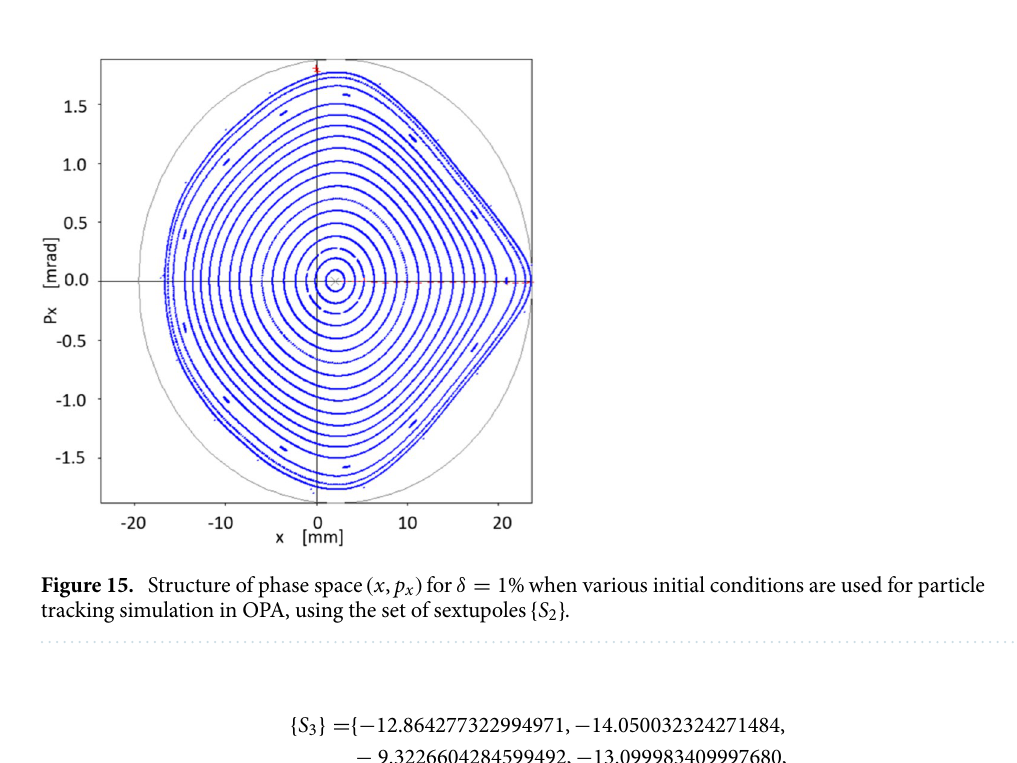
Figure 14. Structure of phase space ( x , p x ) for δ = − 3% when various initial conditions are used for particle tracking simulation in OPA, using the set of sextupoles { S 2 } .